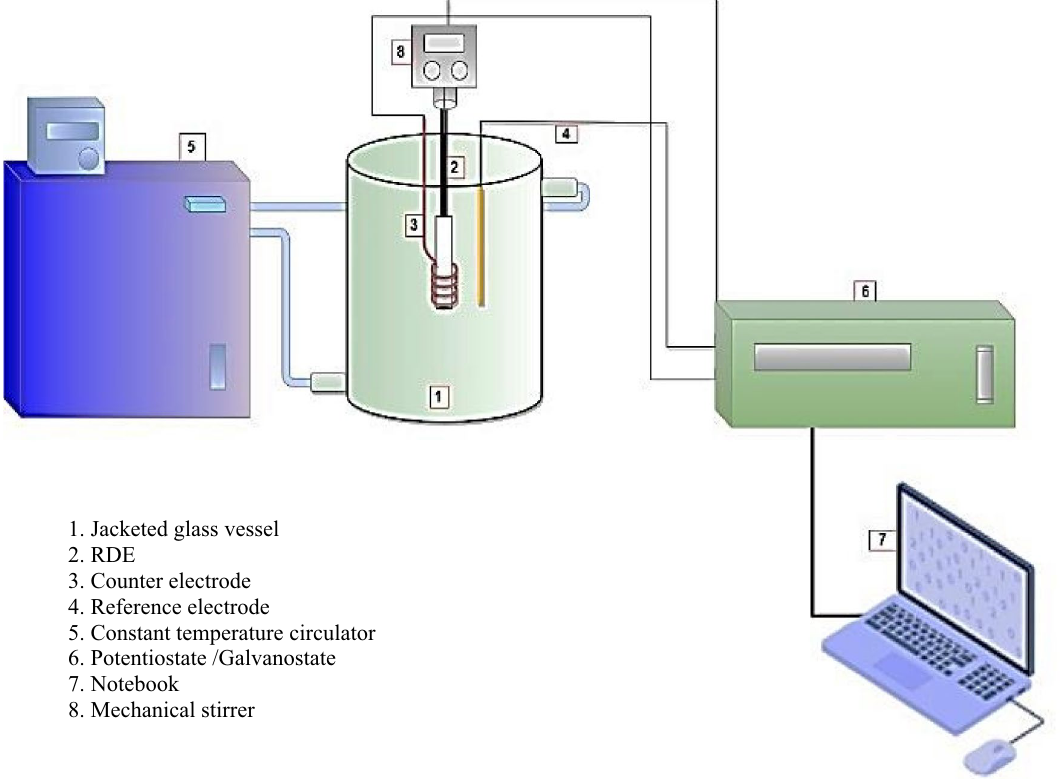
Fig. 5 Schematic view of experimental